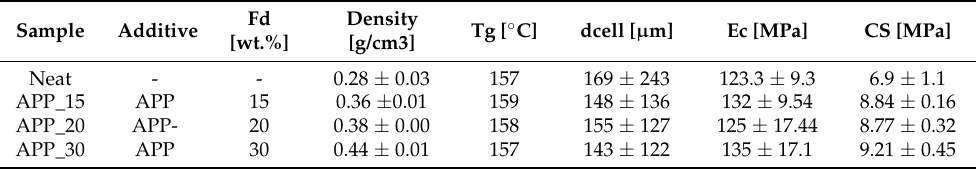
Table 3. Specimens of APP fill study: filler degree (Fd), density, T g , derived from DMA (Peak tan δ ), average foam cell diameter (d cell ), compression modulus (E c ), compressive strength (C s ). Sample Additive Fd [wt.%]